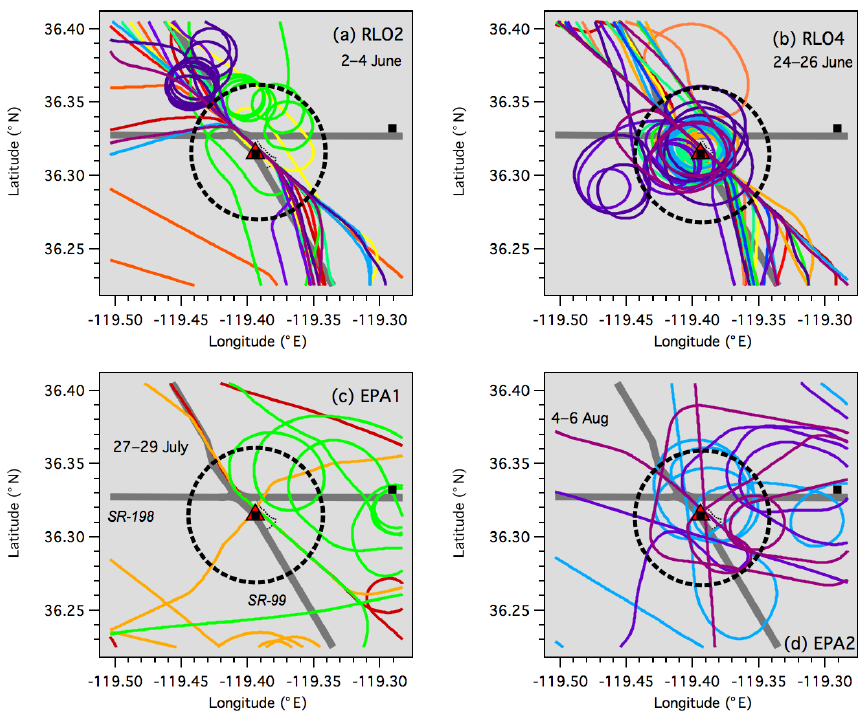
Figure 7. RLO and EPA flight tracks in the vicinity of TOPAZ. (a) RLO2 (2–4 June), (b) RLO4 (24–26 July), (c) EPA1 (27–29 July), and (d) EPA2 (4–6 August). Each color represents a different flight. The red triangle with a black square marks the location of TOPAZ at the VMA and the dashed black circles show the 5km radius used for the profile comparisons. The lone black square represents the Visalia–N. Church St. O 3 monitor.